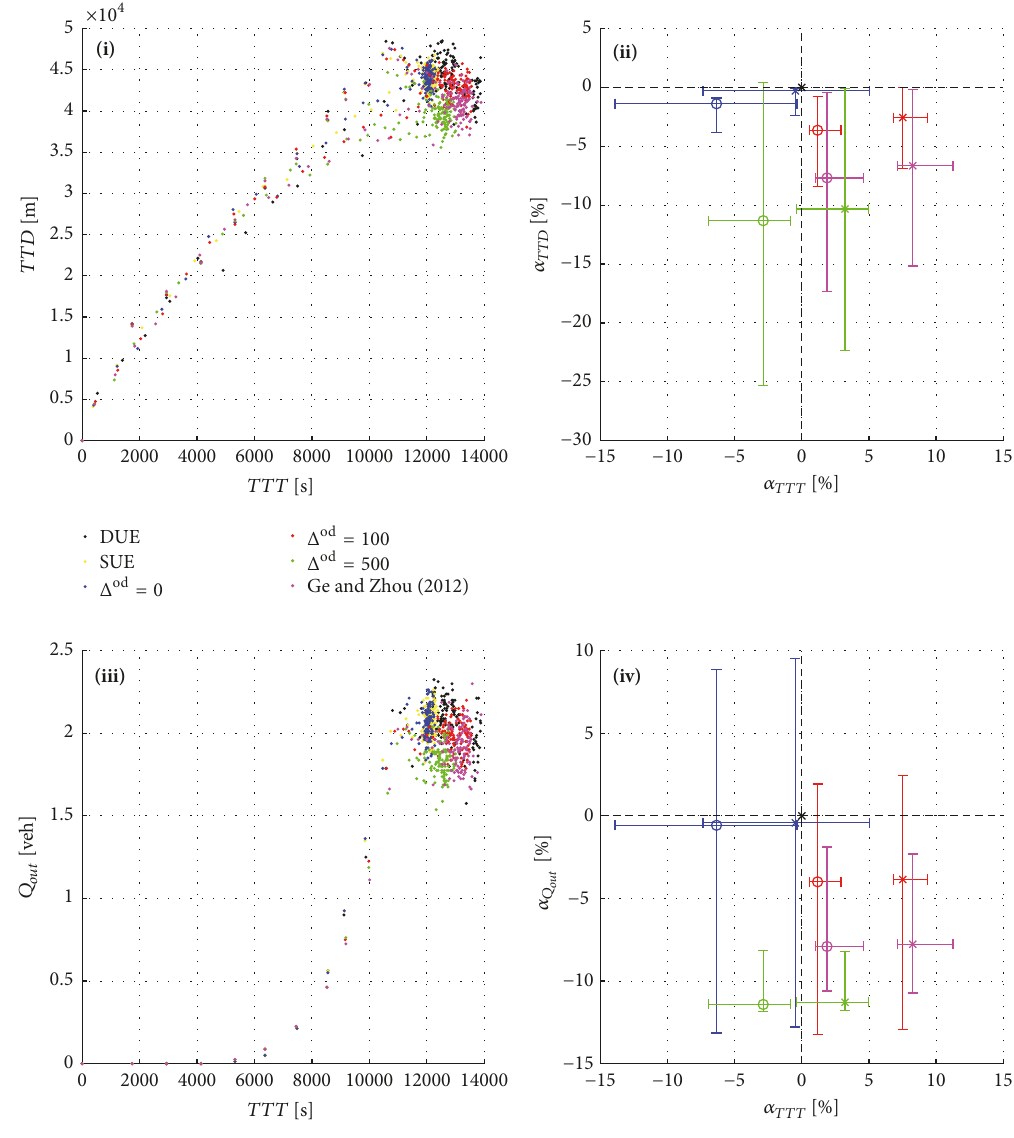
Figure 7: (i) Total travel distance (TTD) [in m] as function of the total travel time (TTT) [in s]. (ii) 𝛼 𝑇𝑇𝐷 versus 𝛼 𝑇𝑇𝑇 for the four settings of the indifference band. (iii) Vehicles outflow ( 𝑄 𝑜𝑢𝑡 ) as function of the total travel time (TTT). (iv) 𝛼 𝑄 of the indifference band. In subplots (i) and (iii) , the results are shown for the DUE, SUE, and the four settings of the indifference band. In subplots (ii) and (iv) , the circle dots represent the relative differences between the four settings of the indifference band and the DUE. The cross dots representthe relativedifferences between the four settings of the indifferenceband and the SUE. These results are for the indifferent preferences search